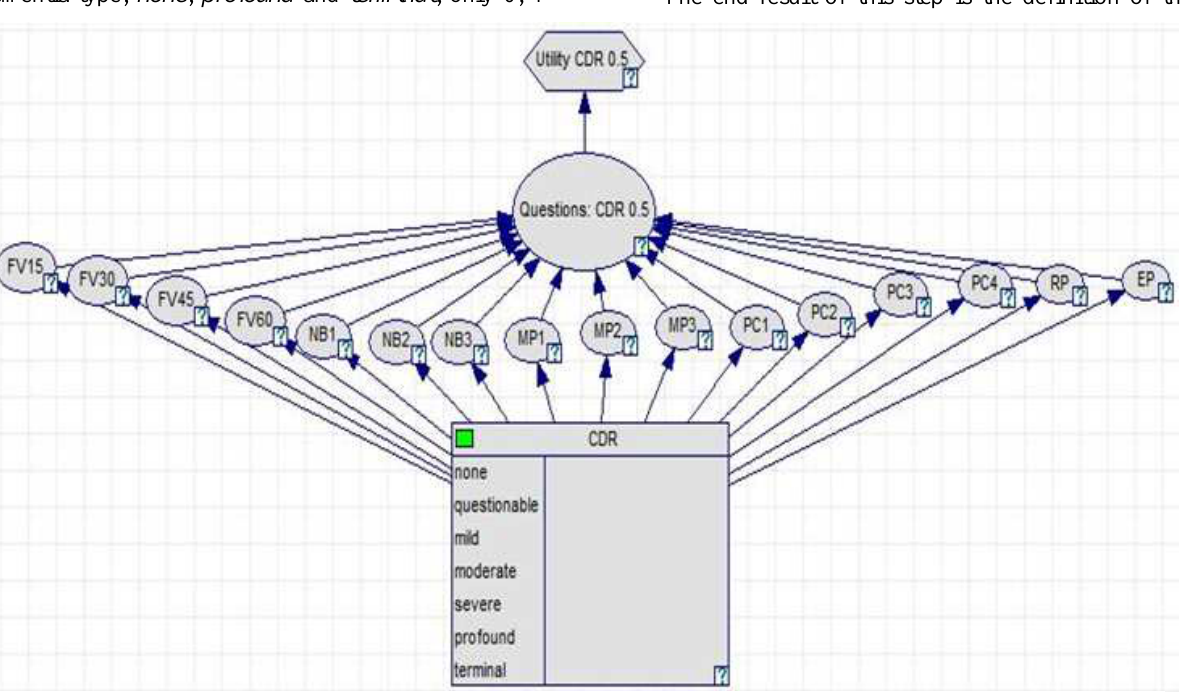
Fig. 2. Hierarchical structure of the decision problem to stage the CDR